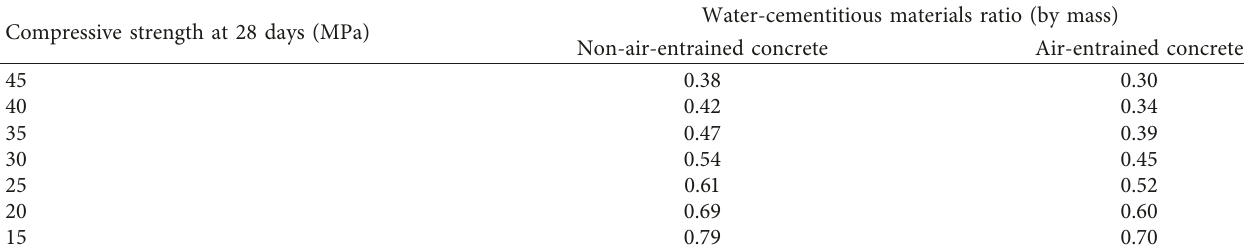
Table 5: Relationship between water to cementitious material ratio and compressive strength of concrete “Table 5 is reproduced